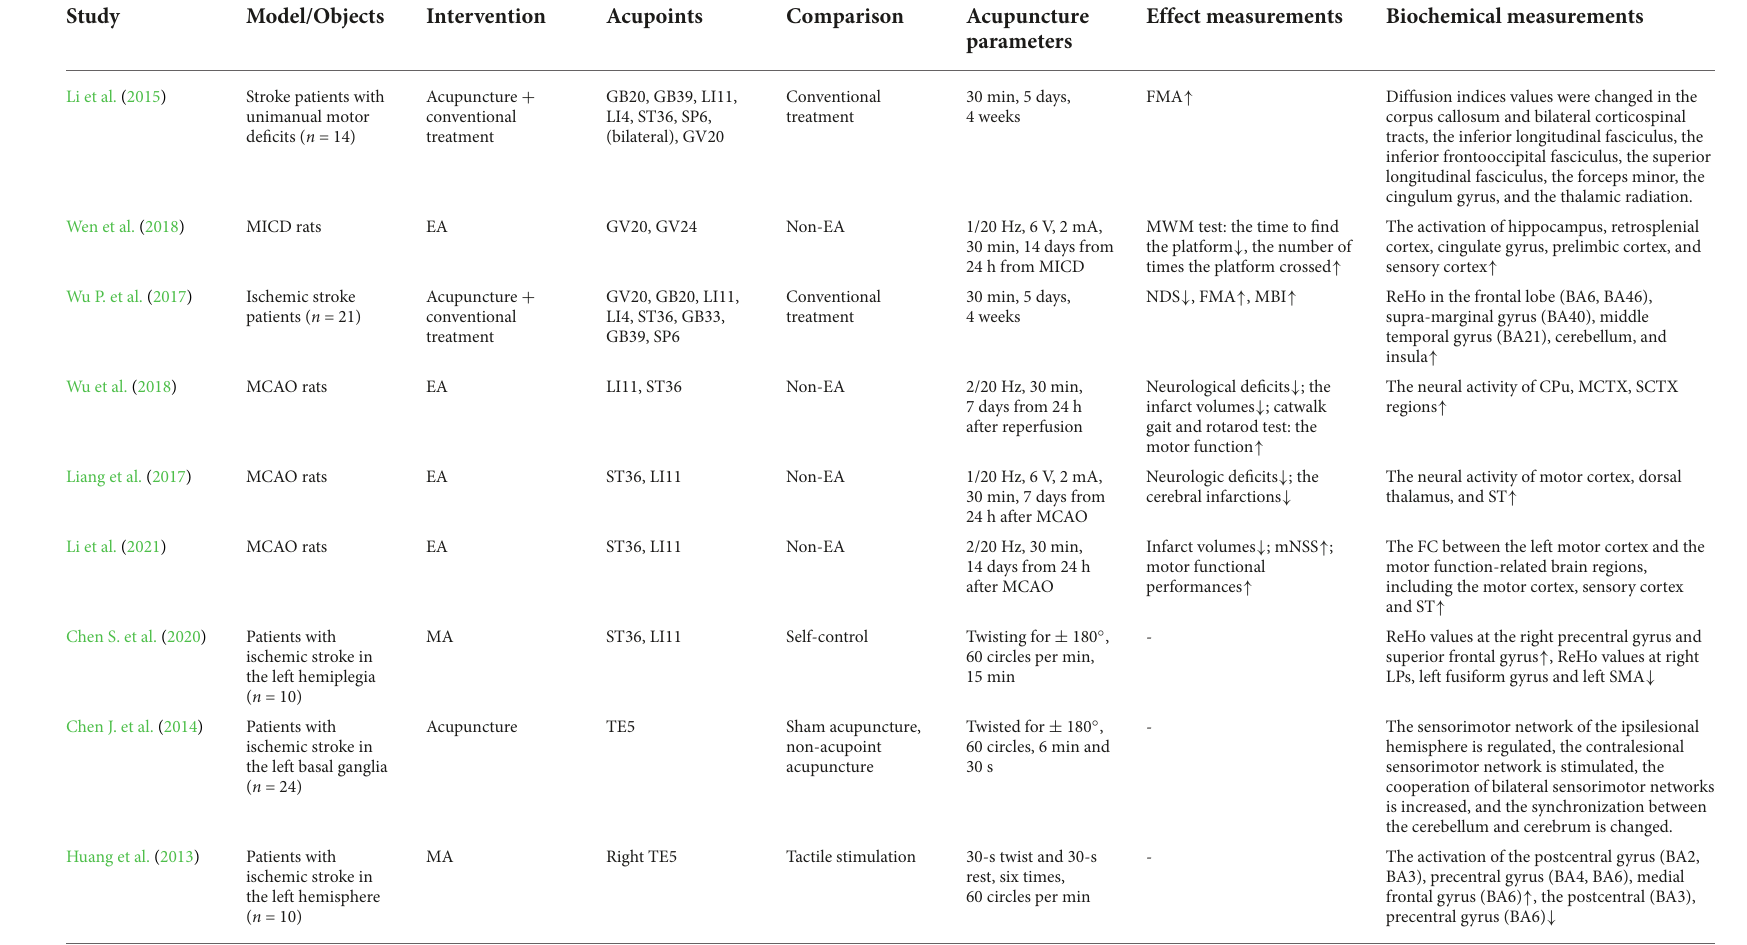
TABLE 3 The mechanisms of acupuncture on regulating functional reorganization in the treatment of ischemic